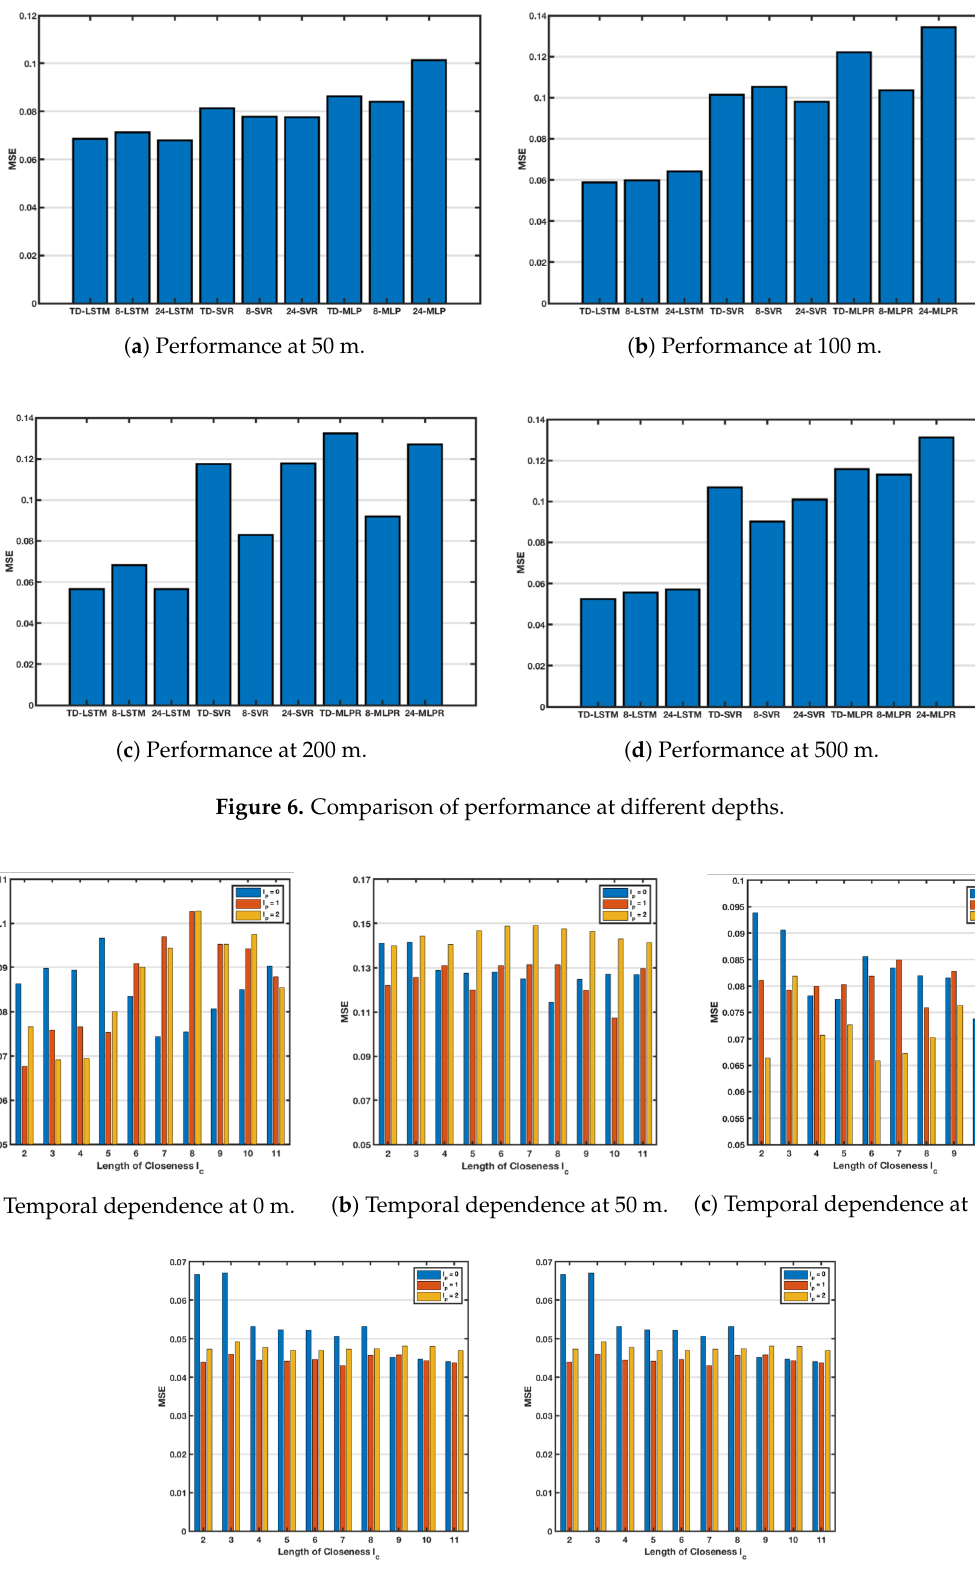
Figure 7. Impact of temporal dependences at different